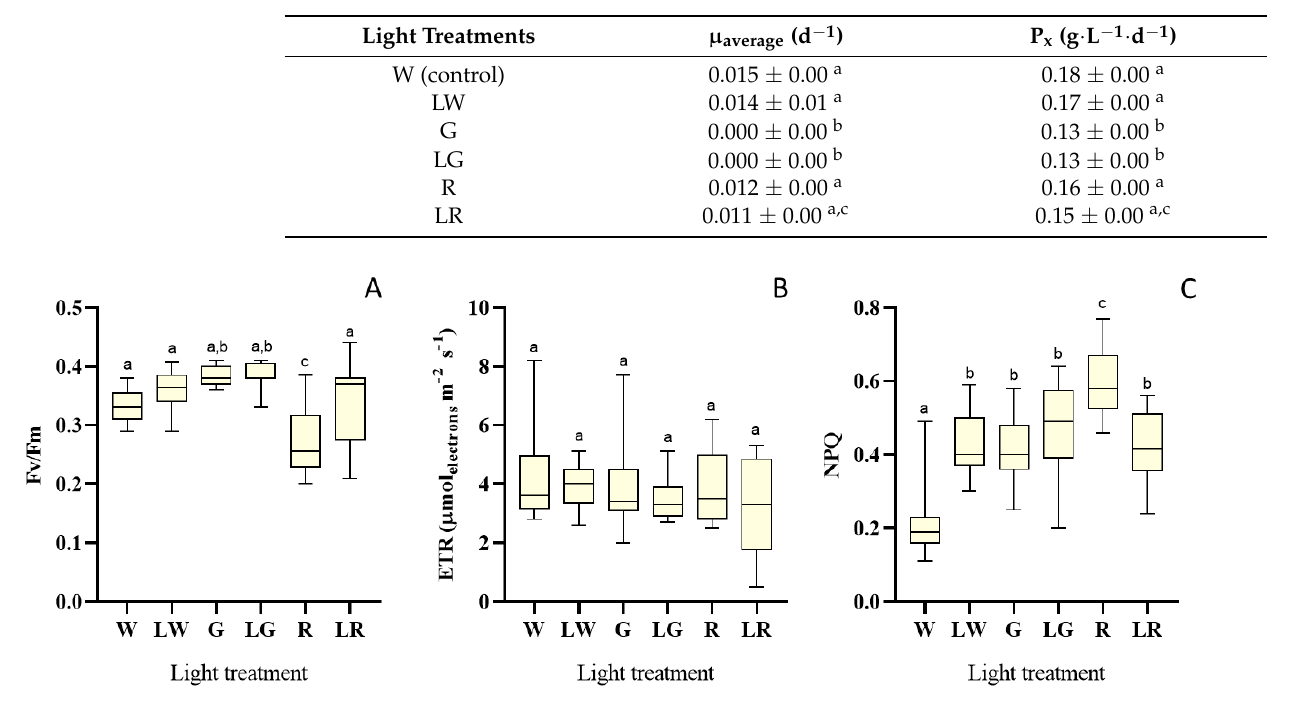
Table 1. Kinetic parameters determined for growth of phase II of S. salina LEGE 06155 cultiva- tion: µ average (average specific growth rate) , expressed in d − 1 , and P x (average productivity), ex- pressed in g · L − 1 · d − 1 for each applied light treatment: W (white, 150 µ mol photons · m − 2 · s − 1 ) (con- trol), LW (low white, 50 µ mol photons · m − 2 · s − 1 ), G (green, 150 µ mol photons · m − 2 · s − 1 ), LW (low green, 50 µ mol photons · m − 2 · s − 1 ), R (red, 150 µ mol photons · m − 2 · s − 1 ), and LR (low red, 50 µ mol photons · m − 2 · s − 1 ).